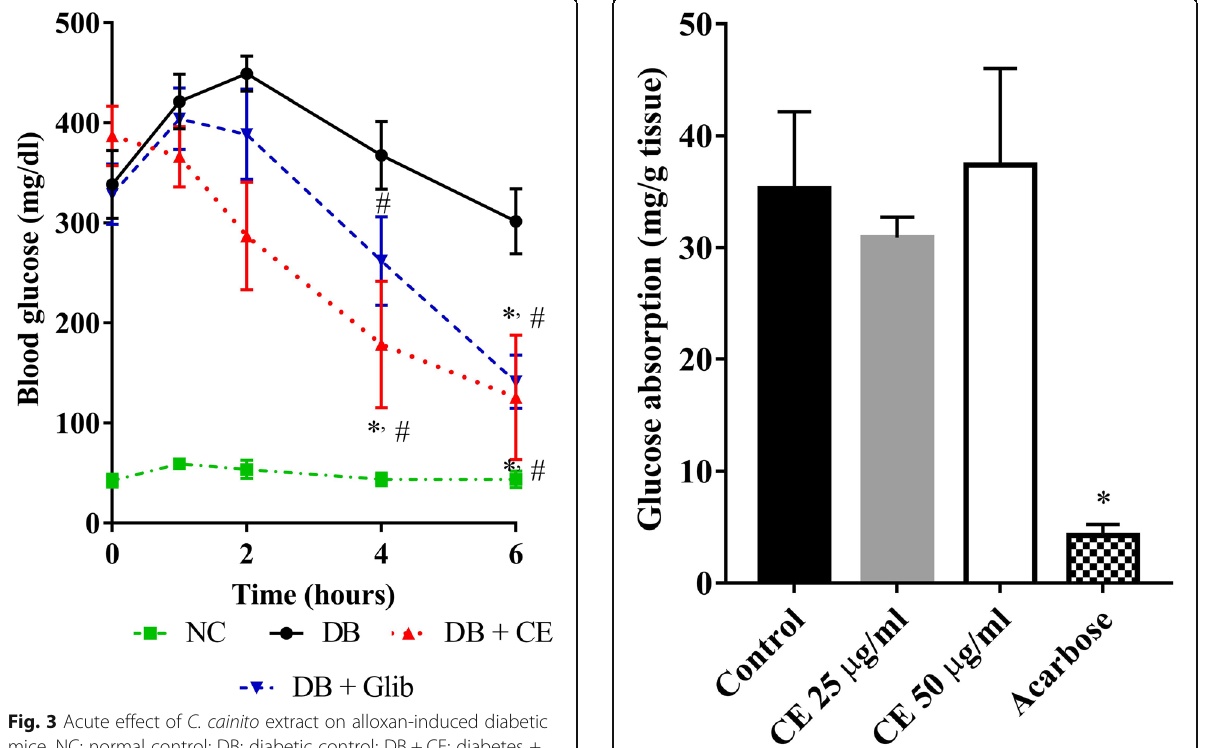
Fig. 4 The effect of C. cainito extract (CE) on glucose absorption by everted mouse jejunum. The values are expressed as mean ± SEM, n = 5. * P < 0.05 compared to control by one-way ANOVA followed by Student-Newman-Keuls as post hoc